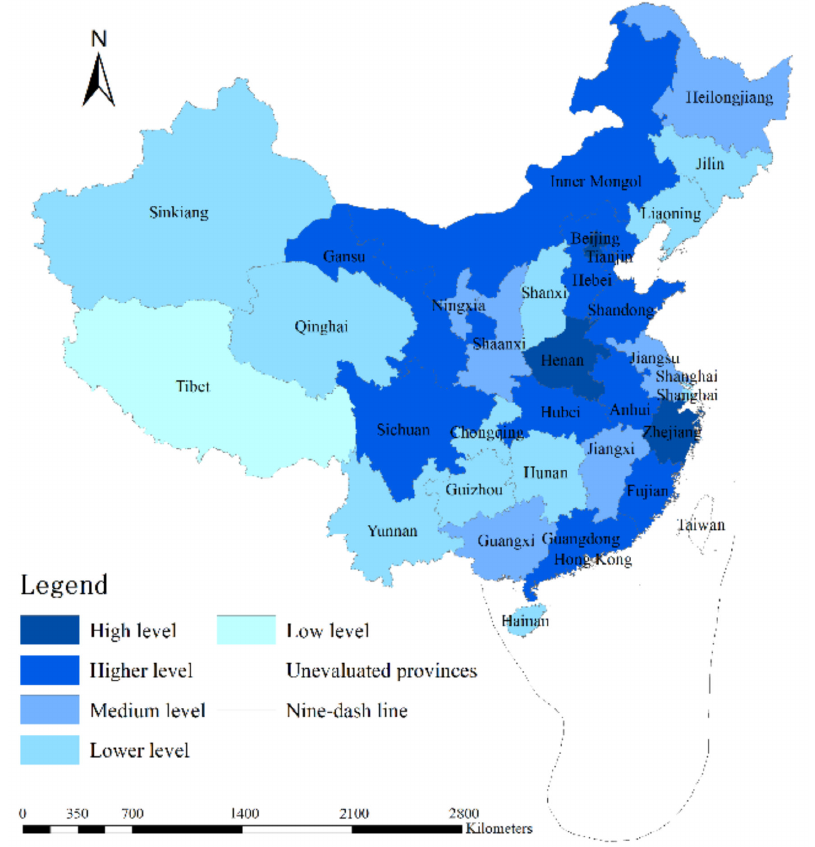
Figure 6. Spatial distribution characteristics of regional water-saving levels in